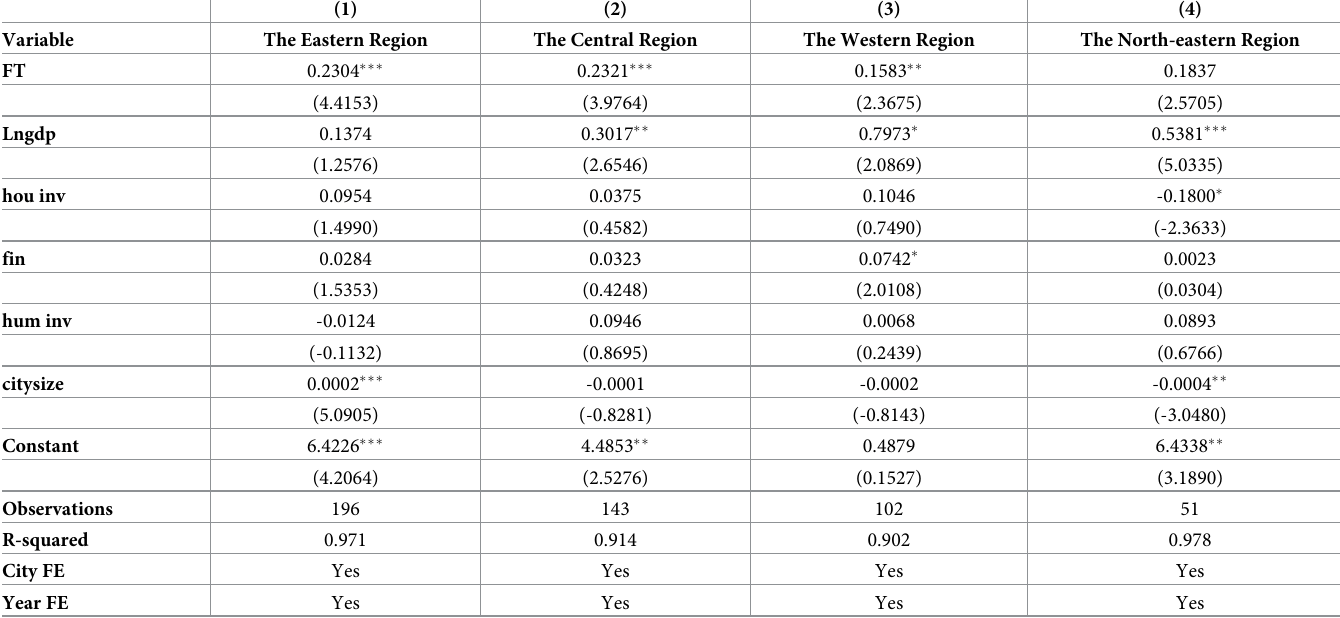
Table 8. Subregional